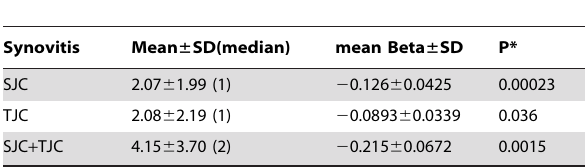
Table 4. Standardized multiple linear regression analysis for air pressure 3 days before evaluations and synovitis among the 326